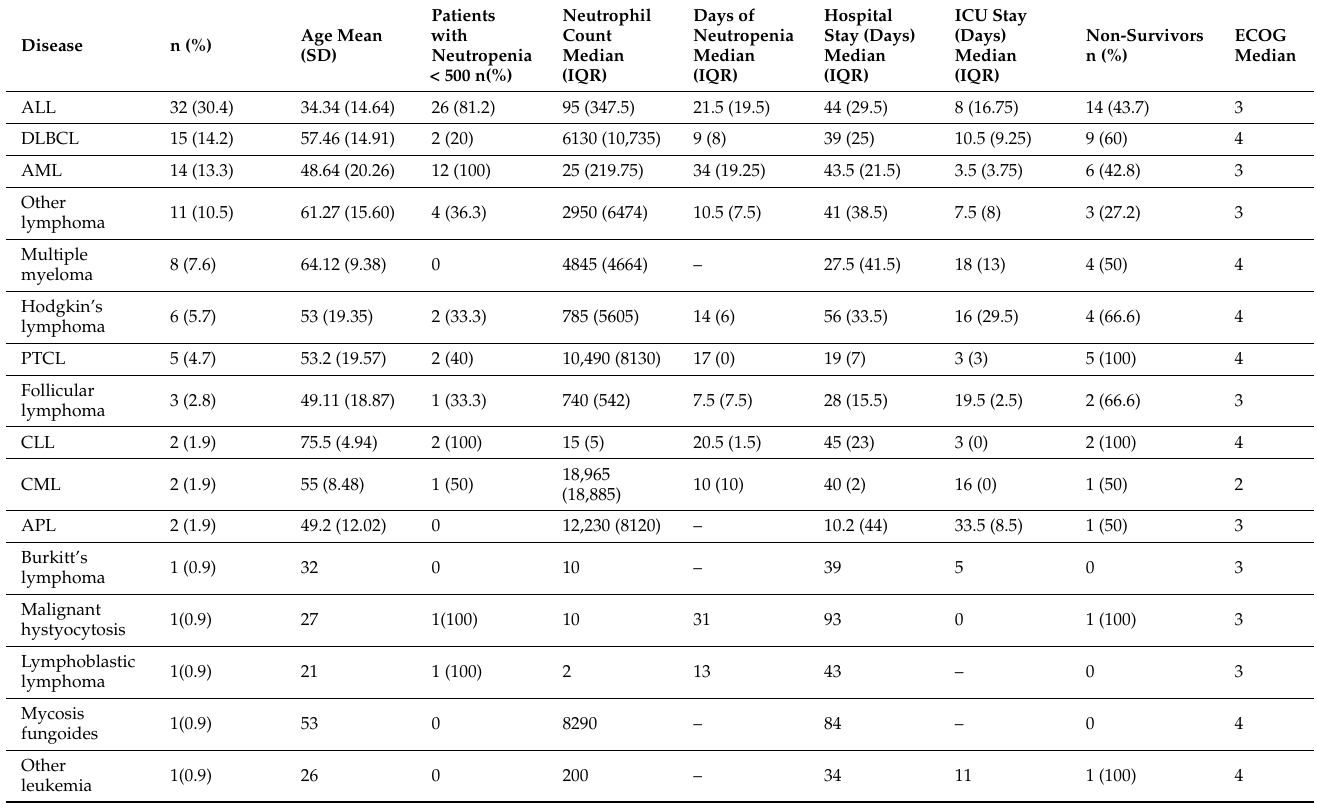
Table 2. Characteristics by hematological